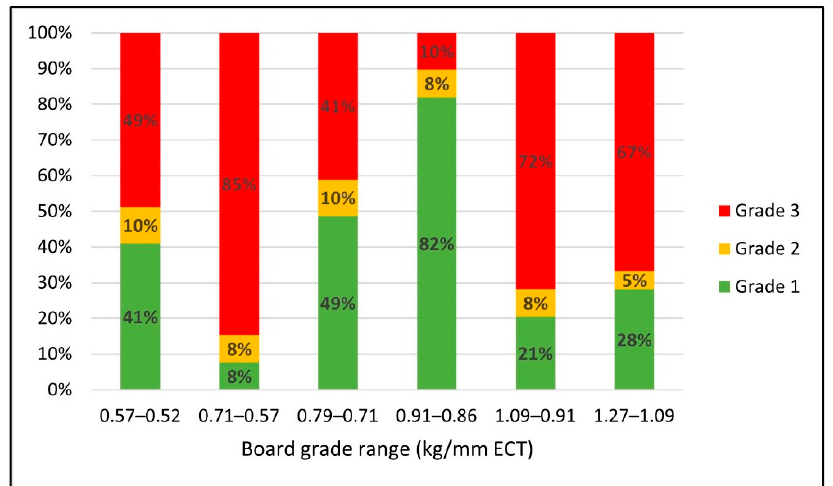
Figure 7. Changes in the proportions of the different grade scenarios in response to the range of board grade reduction.